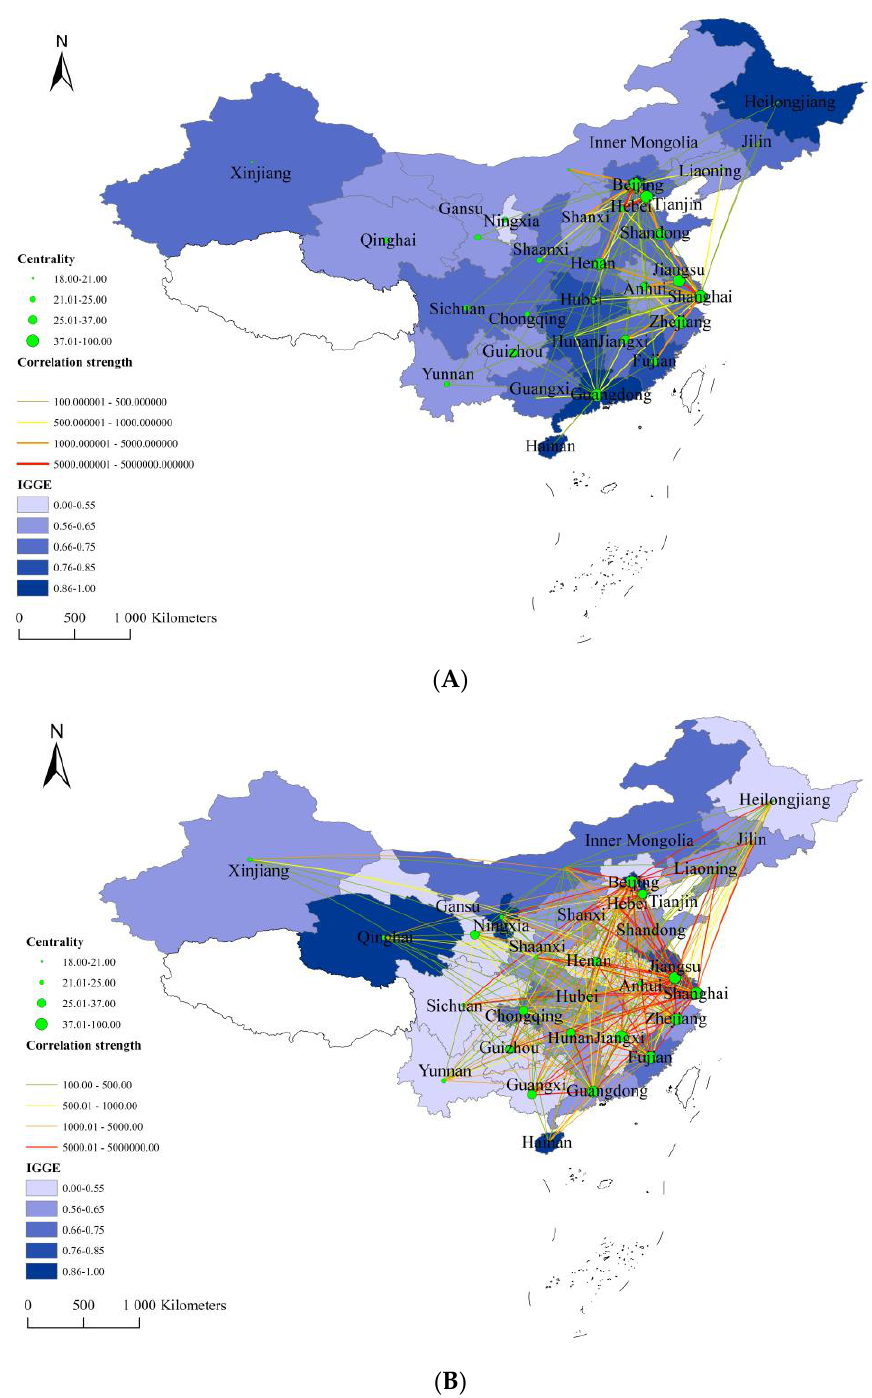
Figure 8. Spatial distribution pattern of the IGGE in 2006 ( A ) and 2020 ( B ).